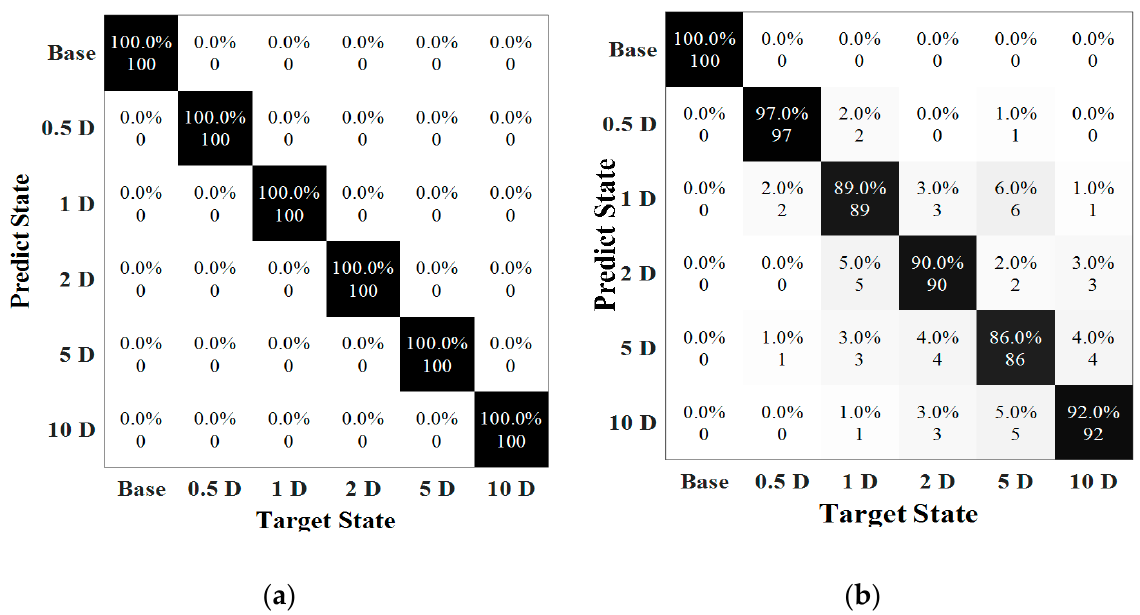
Figure 20. Testing results. ( a ) SNR = 80 dB (Accuracy = 100%); ( b ) SNR = 70 dB (Accuracy = 92.3%).